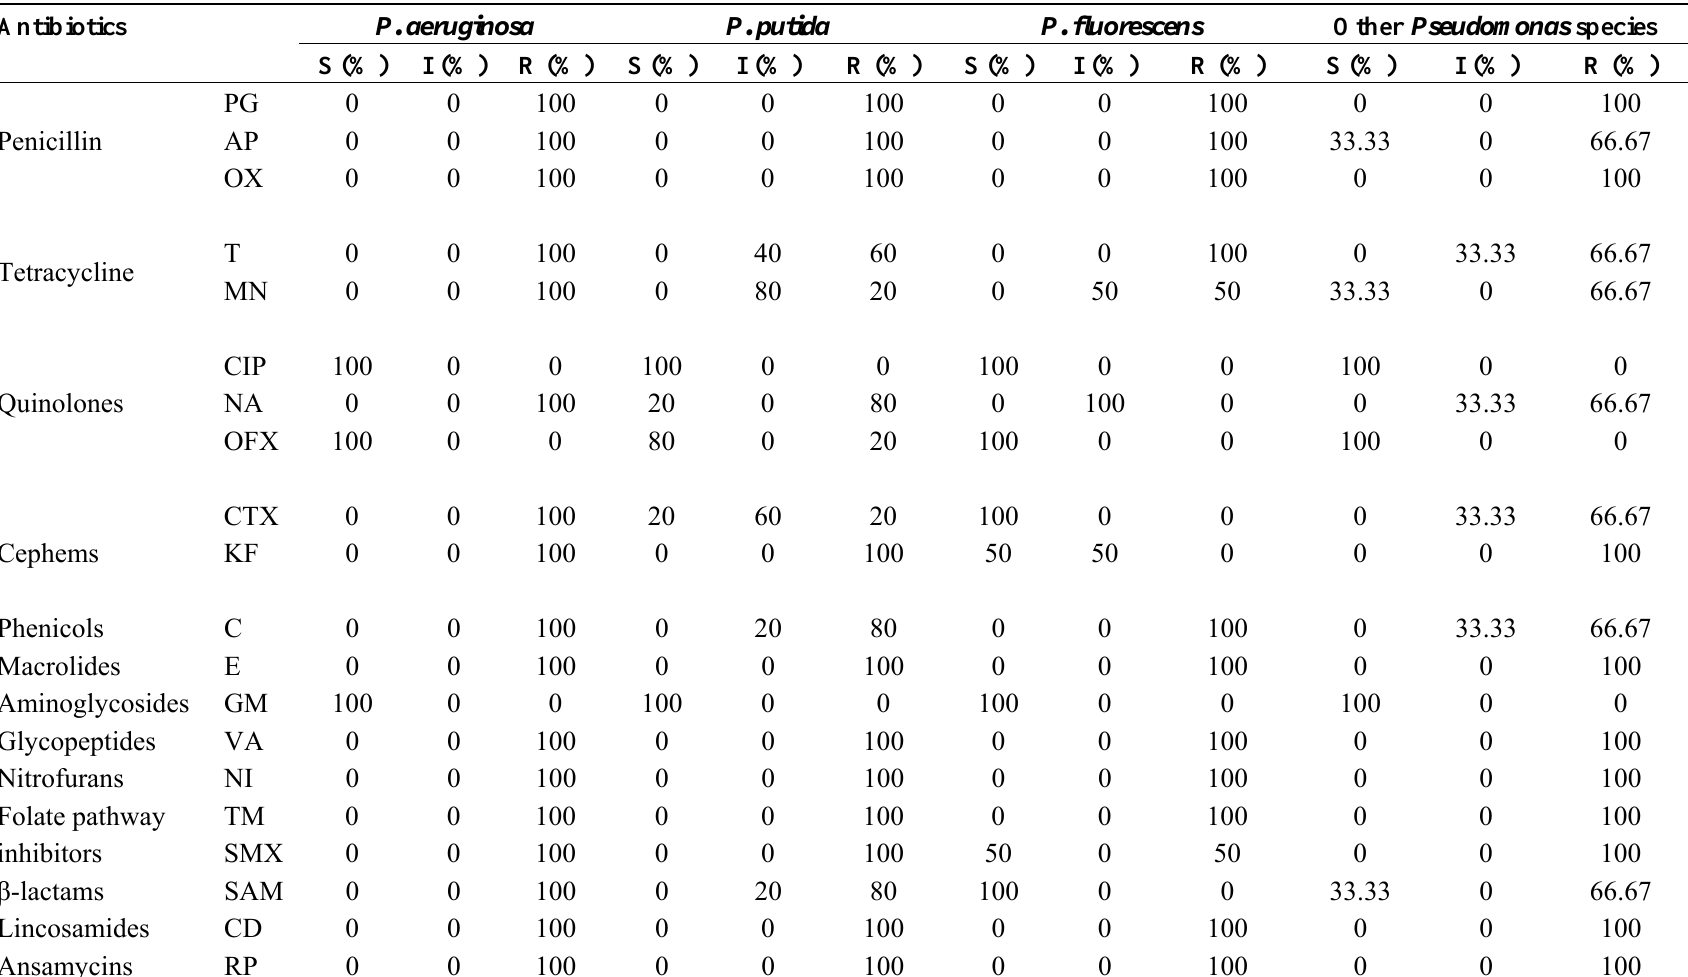
Table 5. Antibiotic susceptibility of Pseudomonas species isolated from freshwater and mixed liquor samples from Fort Beaufort.